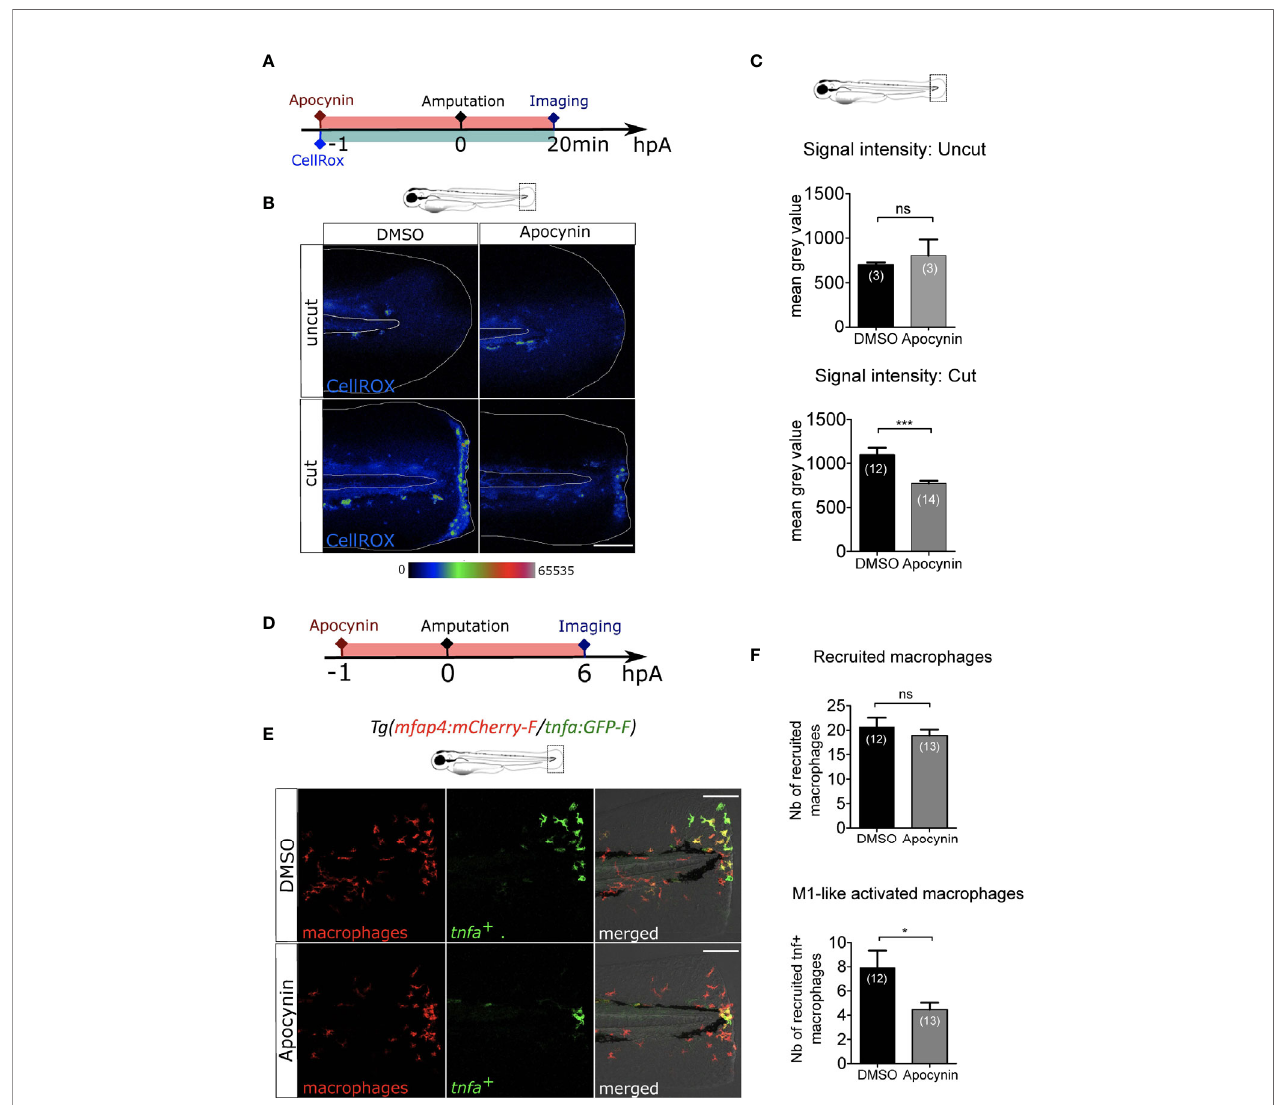
FIGURE 3 | ROS release at the wound mediate macrophage activation but not recruitment. (A) Schedule of the experiment. 1h before the fi n fold injury at 3 dpf, larvae were incubated in Apocynin or DMSO, containing CellROX solution for the detection of the ROS production. Drug and staining were both removed at 20 min pA, and larvae were immediately imaged using epi- fl uorescent microscopy. (B) Representative images of the CellROX fl uorescence in uncut or cut fi n folds, after the treatment with DMSO or Apocynin at 20 min pA. Rainbow color scale was applied to images, emphasizing the differences in signal intensity. The white lines outline the fi n fold and the notochord. Scale bar: 100 m m. (C) Quanti fi cation of signal intensity of the CellROX fl uorescence by mean gray value. Representative experiment of two independent experiments, mean ± SEM, n larvae is indicated in brackets, upper graph: Mann Whitney test, two-tailed, ns – not signi fi cant, bottom graph: